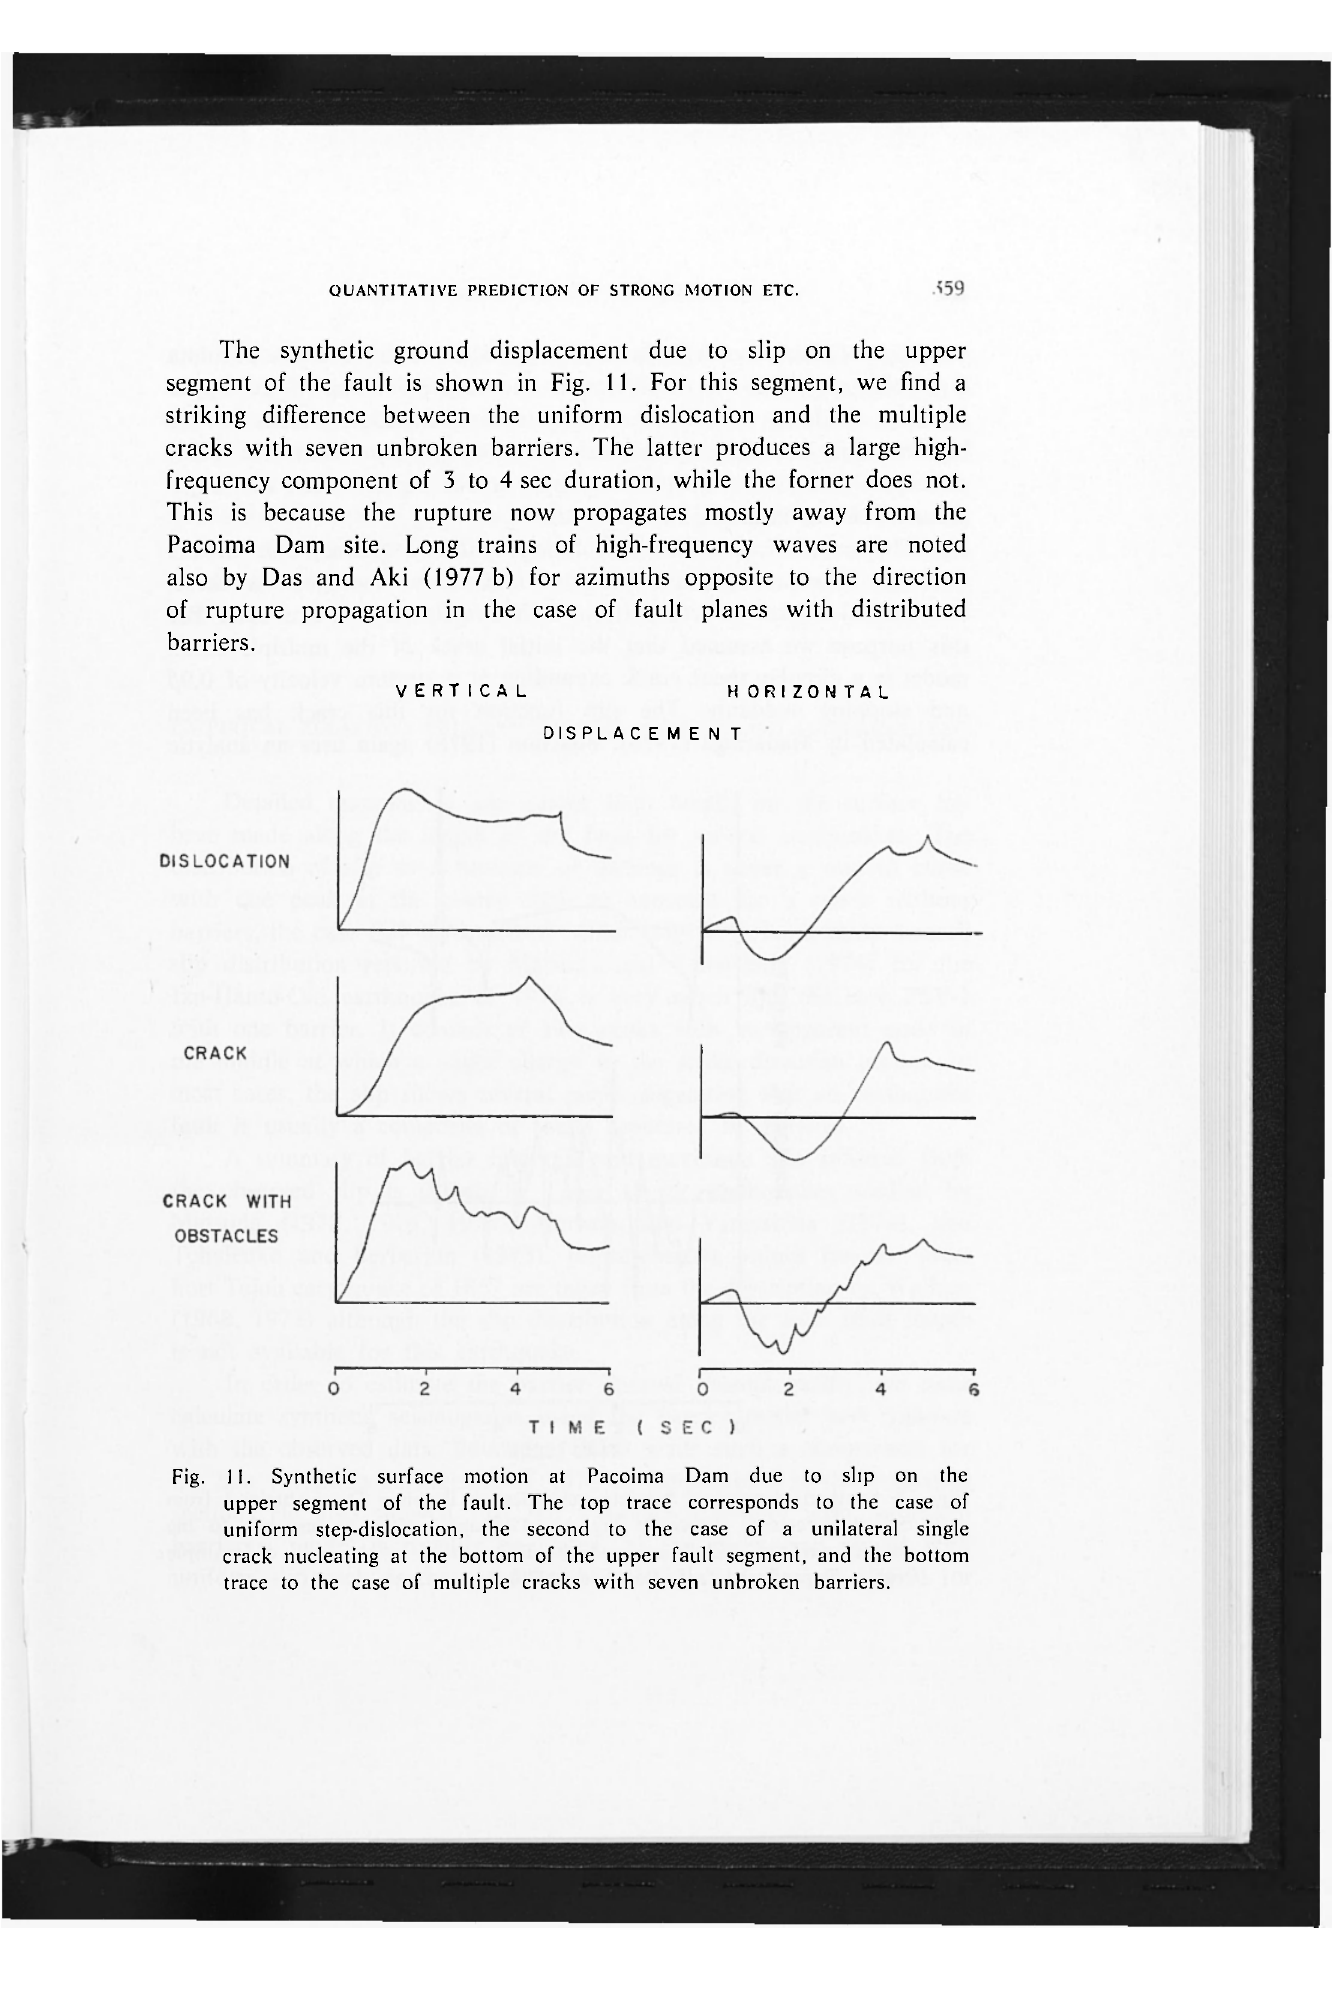
Fig. 11. Synthetic surface motion at Pacoima Dam due to slip on the upper segment of the fault. The top trace corresponds to the case of uniform step-dislocation, the second to the case of a unilateral single crack nucleating at the bottom of the upper fault segment, and the bottom trace to the case of multiple cracks with seven unbroken